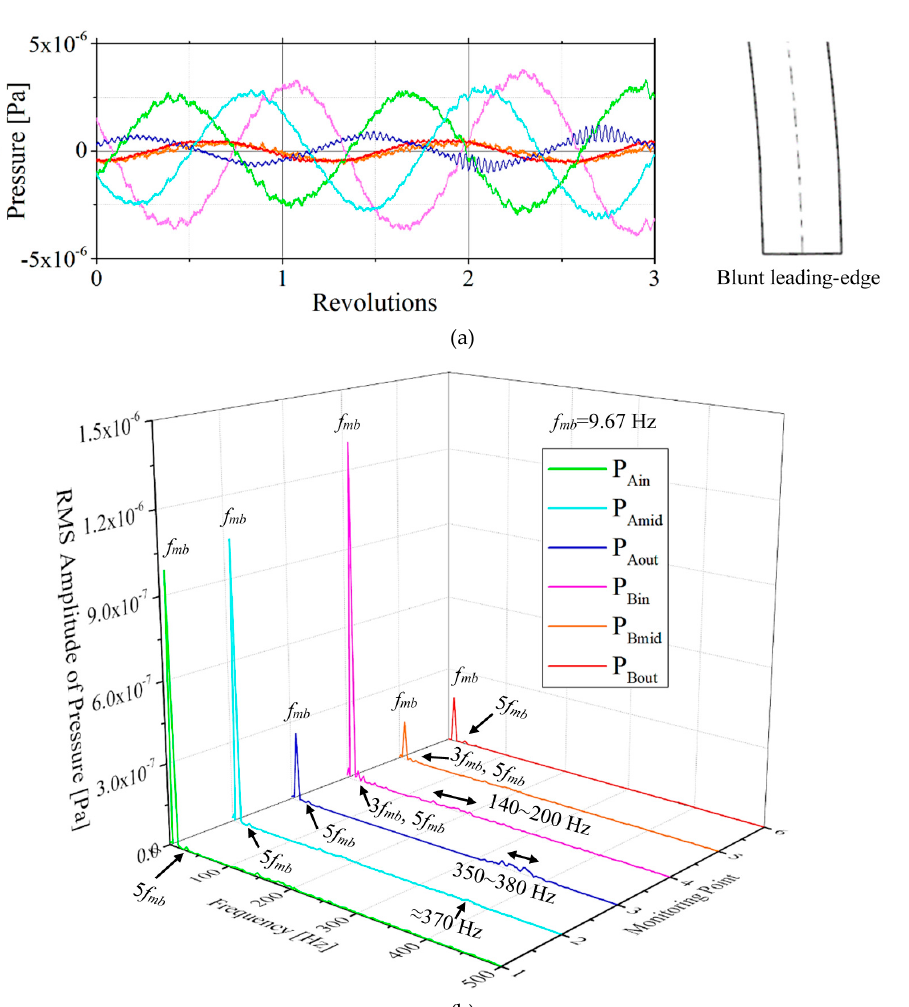
Pressure pulsation in the blunt leading-edge impeller: ( a ) time-domain plot (three revolutions); ( b ) frequency-domain plot, monitor points (1) P Ain , (2) P Amid , (3) P Aout , (4) P Bin , (5) P Bmid , and (6) P Bout .